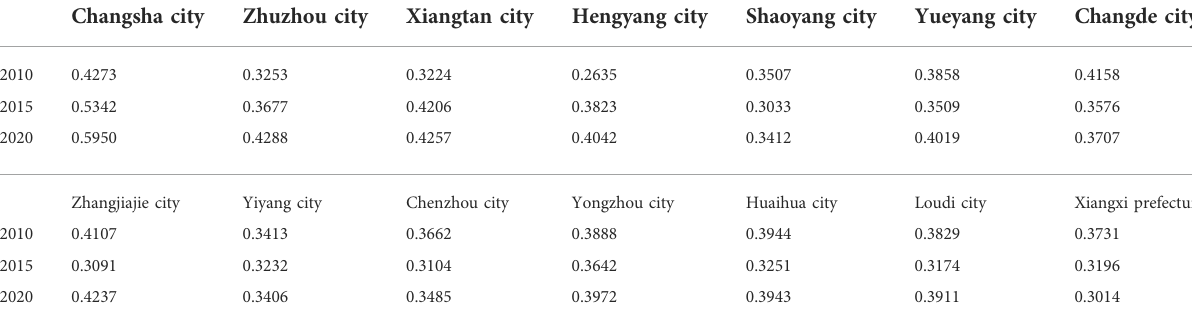
TABLE 2 Score of urban resilience of each administrative region in Hunan Province.